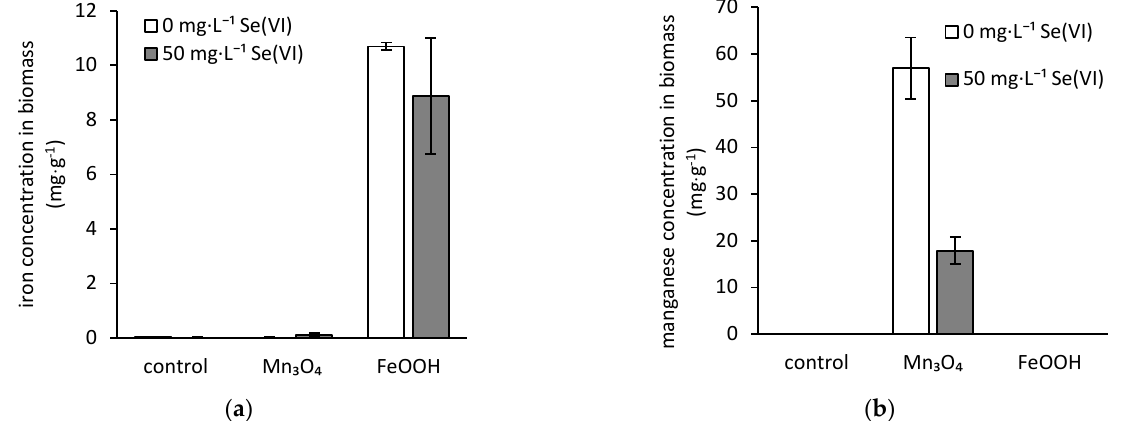
Figure 5. Changes in concentration of ( a ) iron and ( b ) manganese in biomass of Aspergillus niger after being cultivated for three weeks on selenium-free or selenate-treated culture media in the presence of hausmannite (Mn 3 O 4 ) or amorphous ferric oxyhydroxides (FeOOH) (control represents the treatment without any solid inorganic phases). 4. Discussion We have previously reported that the ferric oxyhydroxides have a great affinity for both dominant oxygenated species of selenium in acidic solutions [26,27]. Here, our re- sults showed that after 24 h the amount of removed selenate by amorphous ferric oxyhy- droxides reached 45%. This corresponds to approximately 10.5 mg ⋅ g − 1 sorption capacity, which is similar to other reported values, e.g., the maximum sorption capacities of 15.1